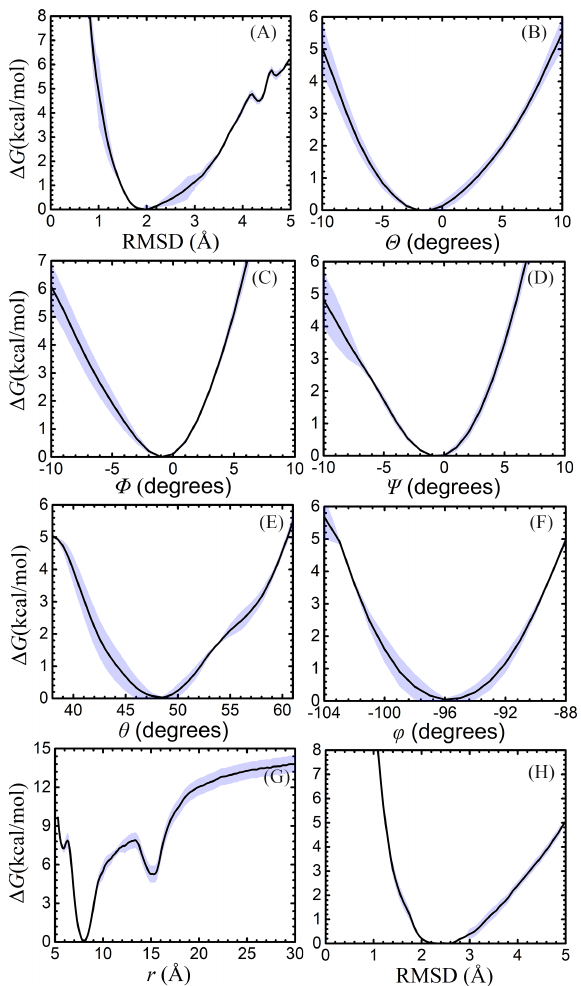
Figure 3. PMFs corresponding to each contribution of Table 1. Plots for the RMSD in the bound state and in the bulk in A and H , for the three Euler angles, Θ , Φ , and Ψ are given in B – D , respectively, for the positional restraints on θ and ϕ in E and F , for the separation in G . The error bars are showed in grey.